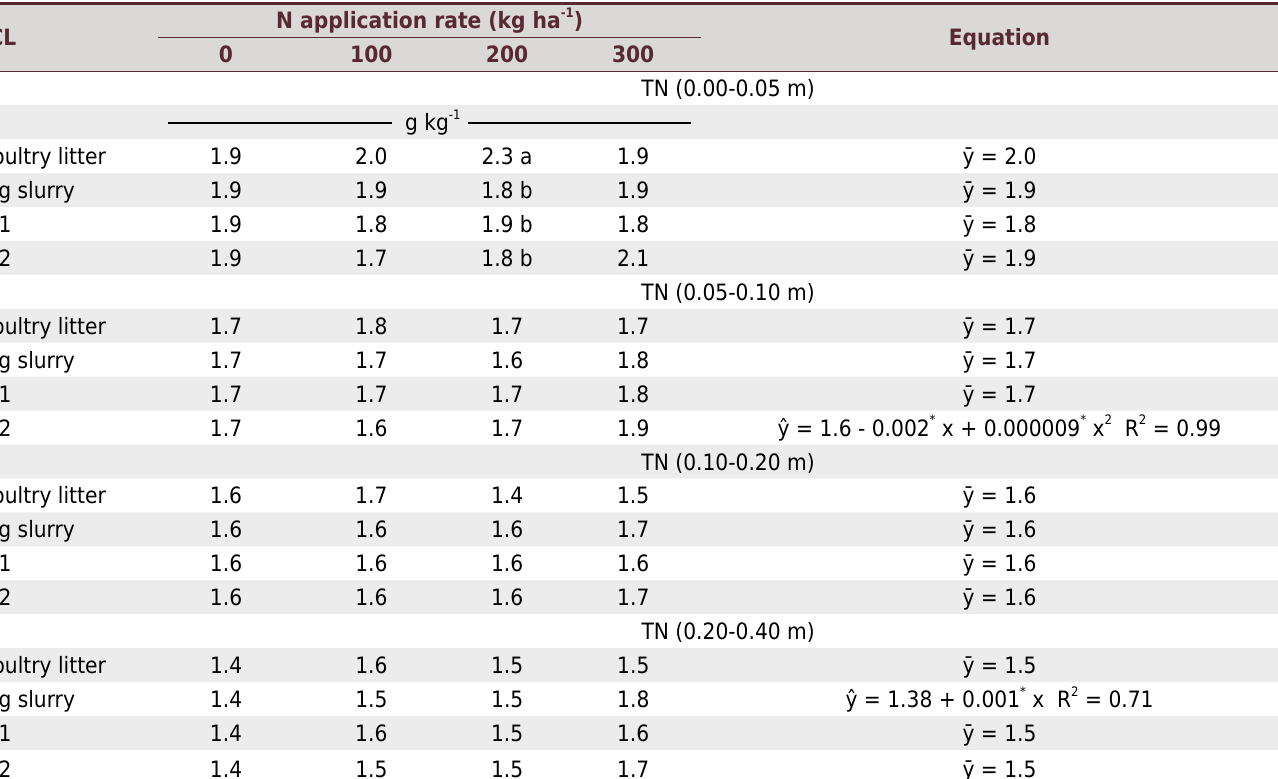
Table 4. Total nitrogen content (TN) in soil according to organic and mineral fertilizer application in integrated crop-livestock systems in 2013 N application rate (kg ha -1 ) ICL